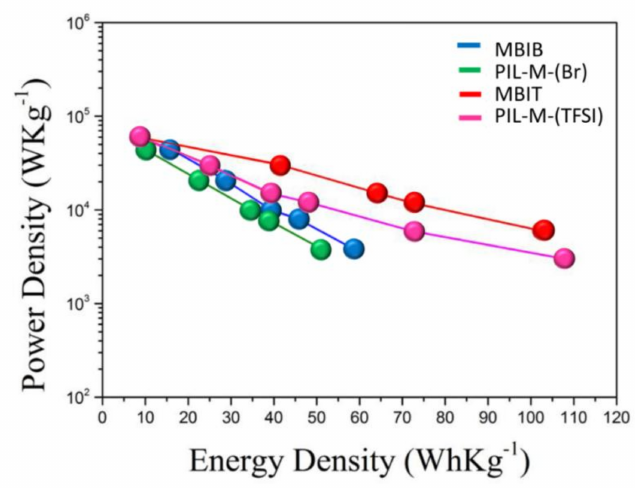
Figure 12. Ragone plot of MBIB and PIL-M-(Br − )-based supercapacitors.